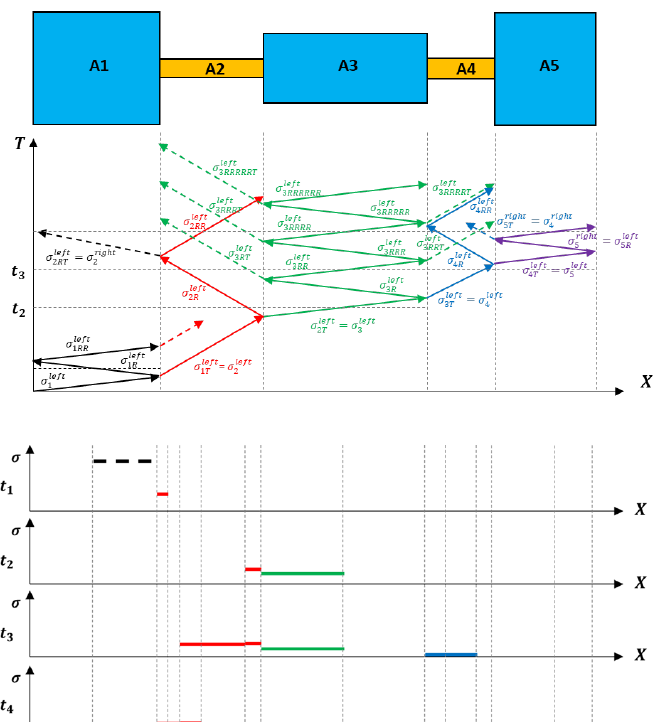
Figure 5: a.) Simplification of Gen. III sample to a one-dimensional beam model and the traces of the stress waves (reflections and transmissions); b.) the stress wave amplitude in different areas (constant -value of 8 was used), location X and time t, t1: begin of the wave propagation, t2-t4: increasing time of wave 𝛼𝛼